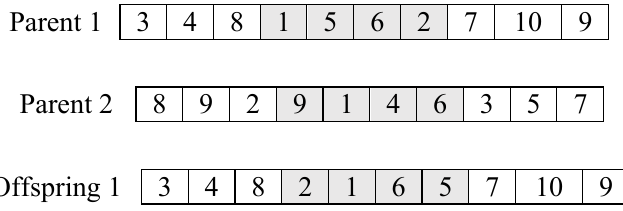
Fig. 4. MOX crossover operator applied for the ordering part